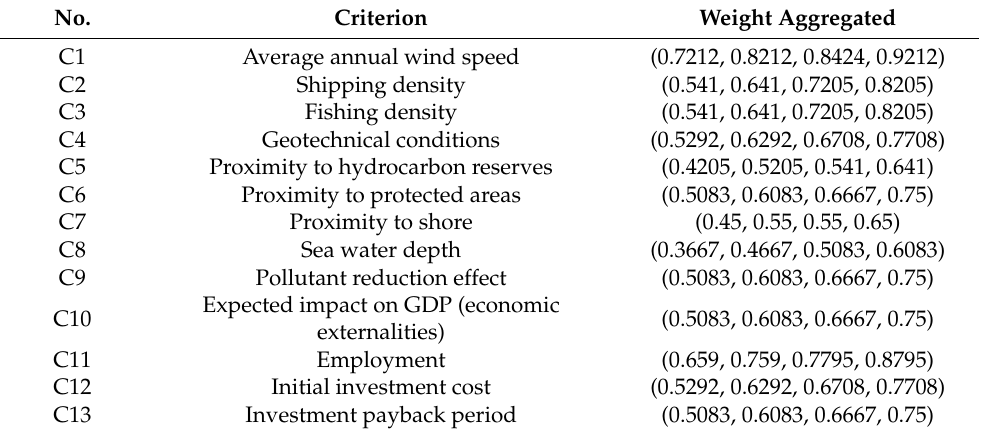
Table 7. Aggregated expert criteria